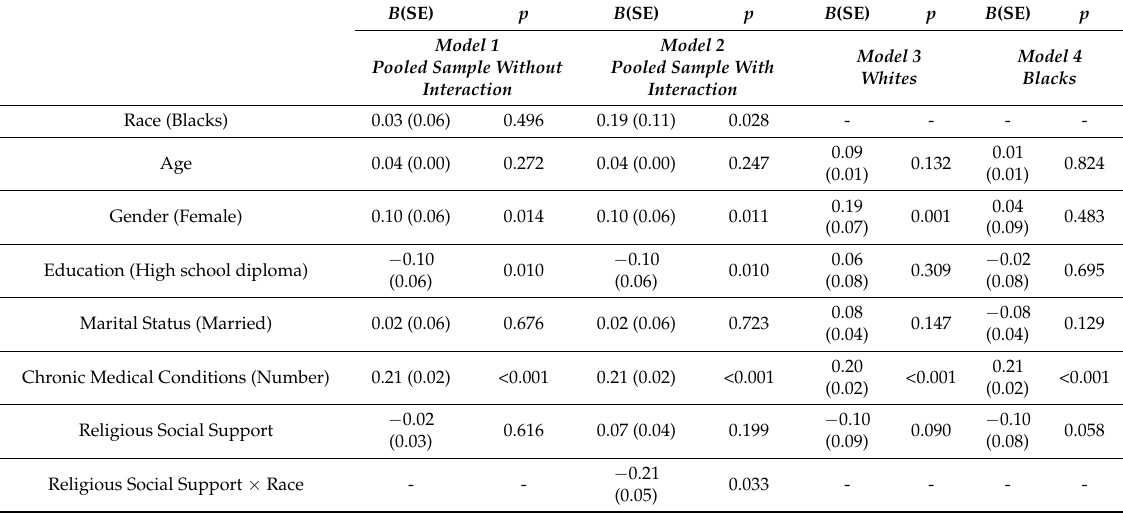
Table 3. Effects of religious social support on depressive symptoms based on race in older adults using linear